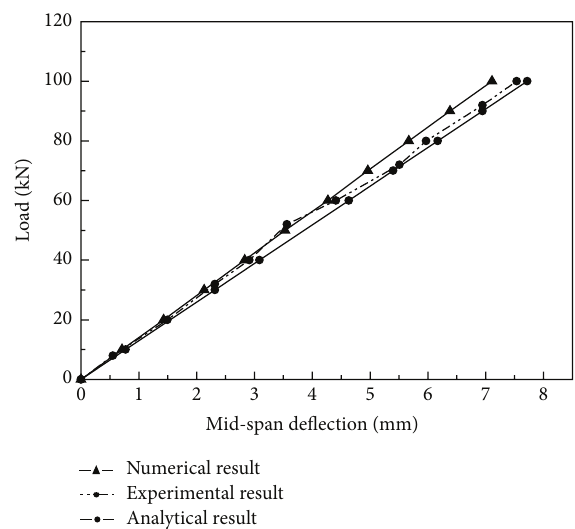
mid-span deflection decreases is large; conversely, when the thickness of the facesheet is increased above 4.5 mm, the rate of decrease is less significant. This is also true for the normal stress of the mid-span panel. Therefore, for a sandwich beam with a total height of 95 mm, it is most effective to use a 4.5 mm thick